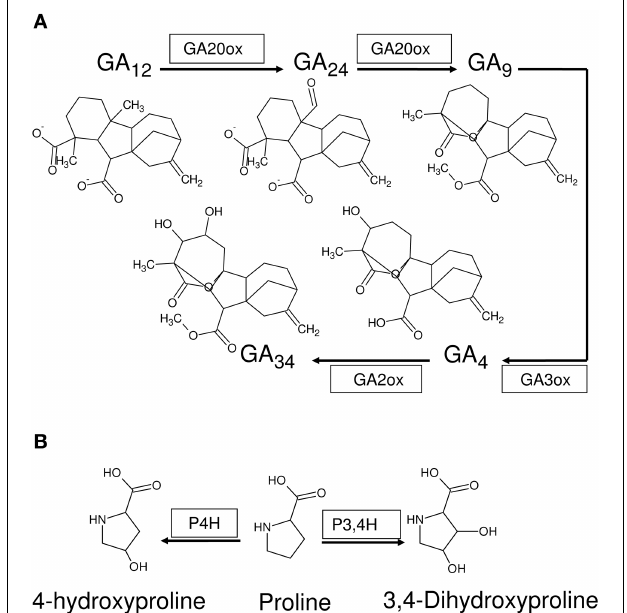
FIGURE 7 | 2-oxoglutarate-dependent dioxygenases as stimulus reinforcers. (A) Anabolic (GA20ox, GA3ox) and catabolic (GA2ox) alpha-ketoglutarate dependent enzymes function to prepare a cell mileau conducive to growth and development (increased formation and storage of alkaloids, expansins, glycosylases, and decreased formation of lignins) and a modulatory antioxidant process (formation of flavonoids). (B) Plant P4Hs catalyze the hydroxylation of proline-rich peptide segments of cell wall glycoproteins, stabilizing the macromolecule. Conversely, decreased activity might result in loosely networked unstable components, that are required for continued